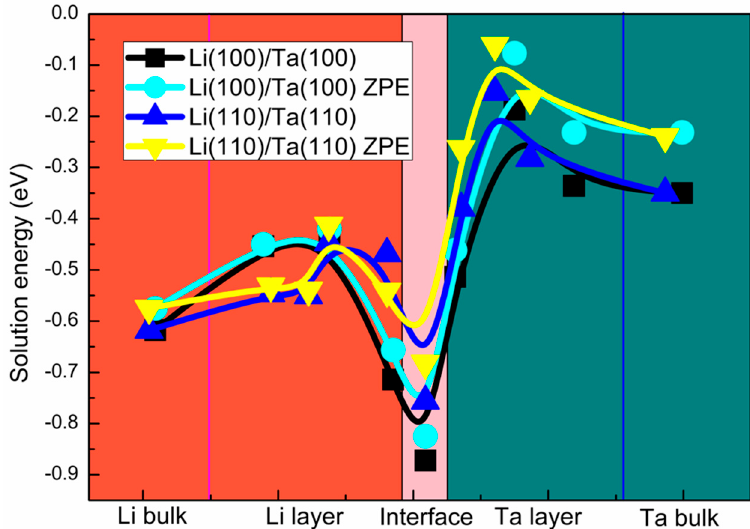
Figure 3. The solution energies of the H atoms at the interstitial sites in Li(100)/Ta(100) and Li(110)/Ta(110) bilayers.